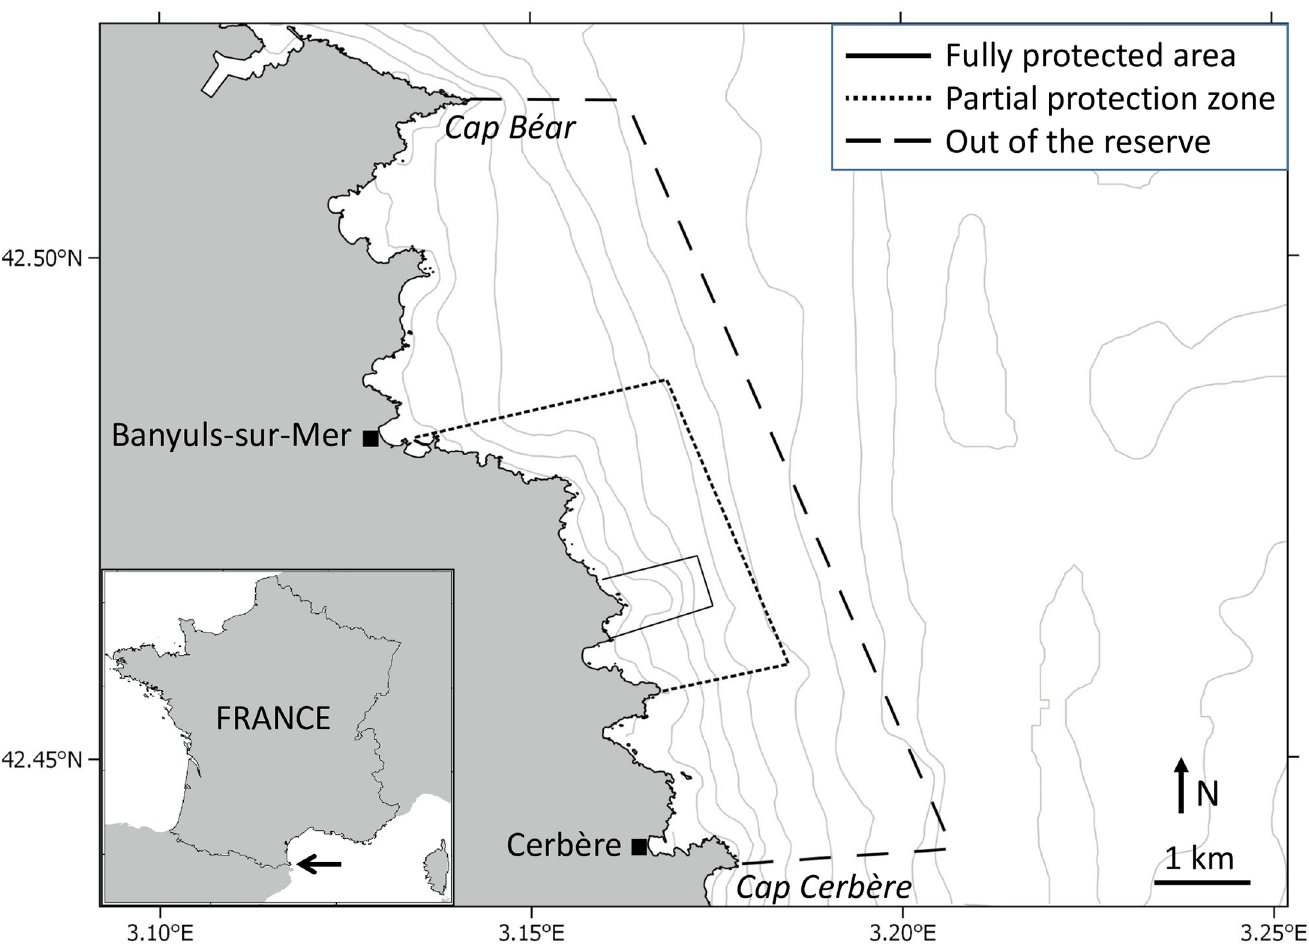
Fig 1. Map of the study area indicating the position of the Cerb è re-Banyuls marine reserve’s fully protected core area (no-take zone), buffer zone of partial protection (fishing allowed with restrictions, see Methods), and control outside area (no specific regulation on fishing) in relation to the towns of Banyuls-sur- Mer and Cerb è re and the two capes, Cap Be´ar and Cap Cerb è re. Established in 1974, Cerb è re-Banyuls is one of the oldest marine protected areas of the Mediterranean Sea. The arrow in the insert indicates the position of the reserve in the natural marine park of the Gulf of Lion situated in the north-western corner of the Mediterranean, at the border between France and Spain. Isobaths indicate depth variation every 10 meters. Maps were produced using the open source program QGIS.